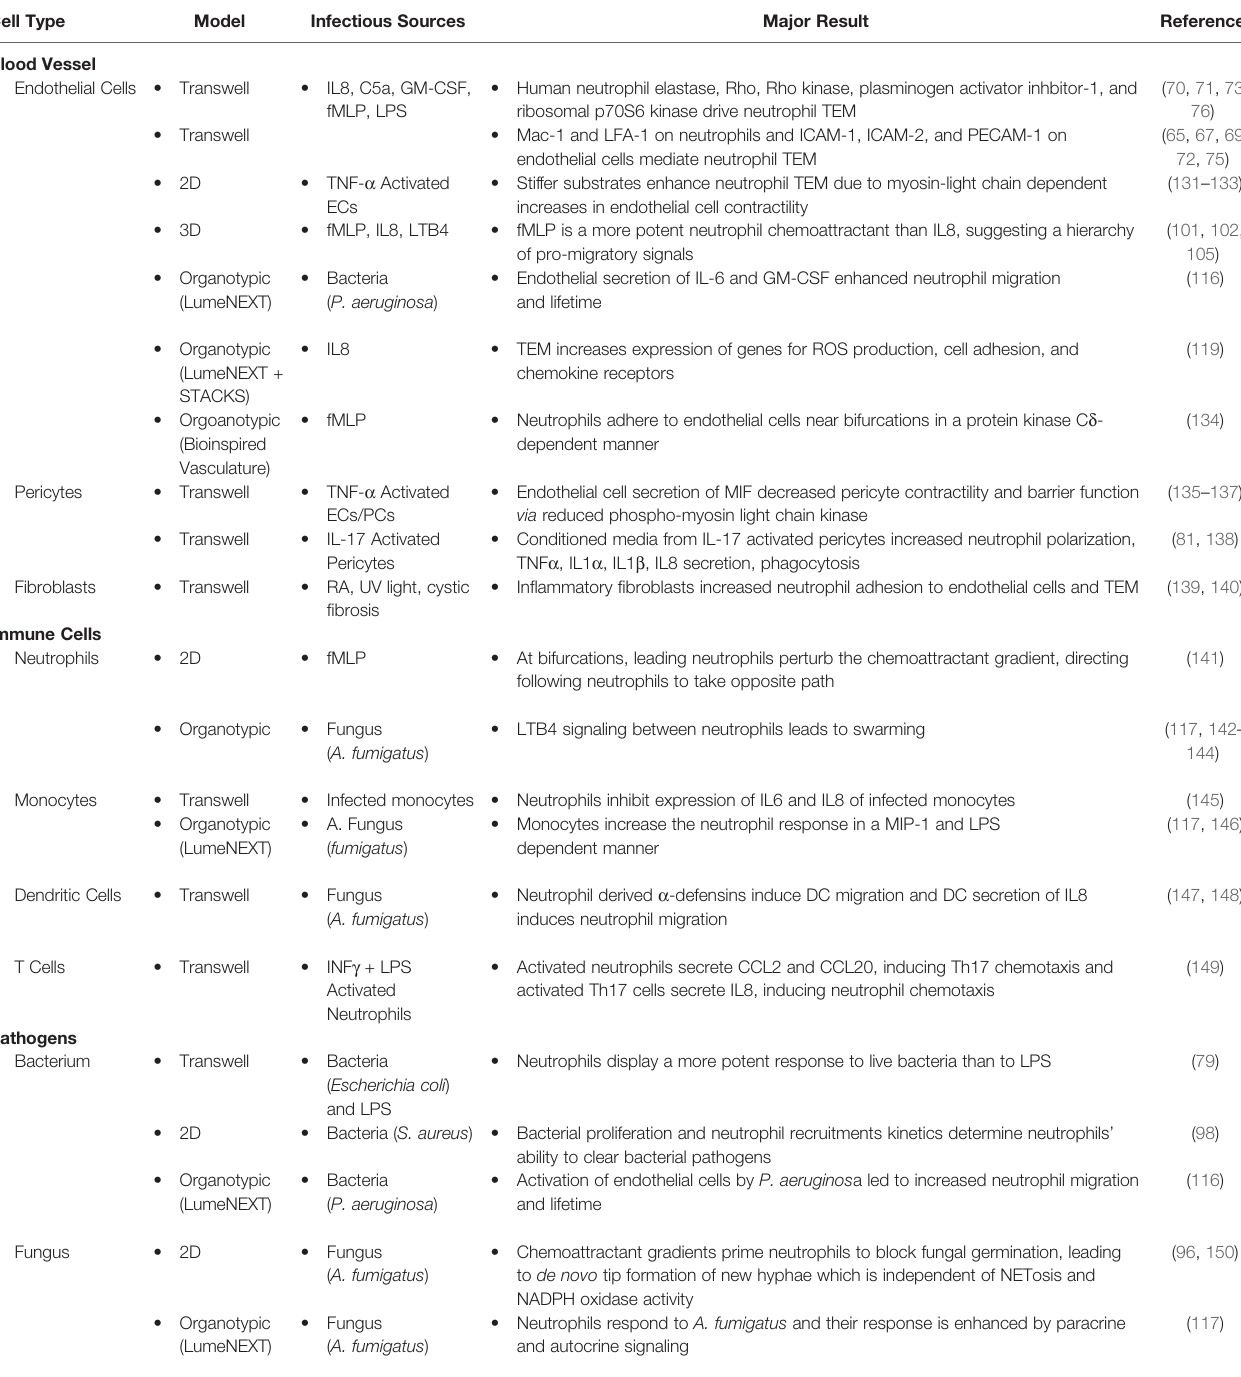
TABLE 1 | Summary of